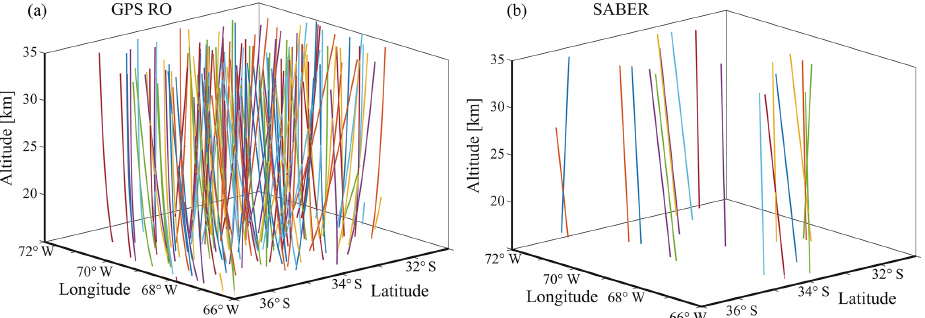
Figure 4. (a) LTPs corresponding to available profiles during the period January–February 2009, retrieved from tropo-stratospheric GPS-RO events (see text). (b) The same as (a) , for SABER measurements. Arbitrary colors were included to make easier the visual